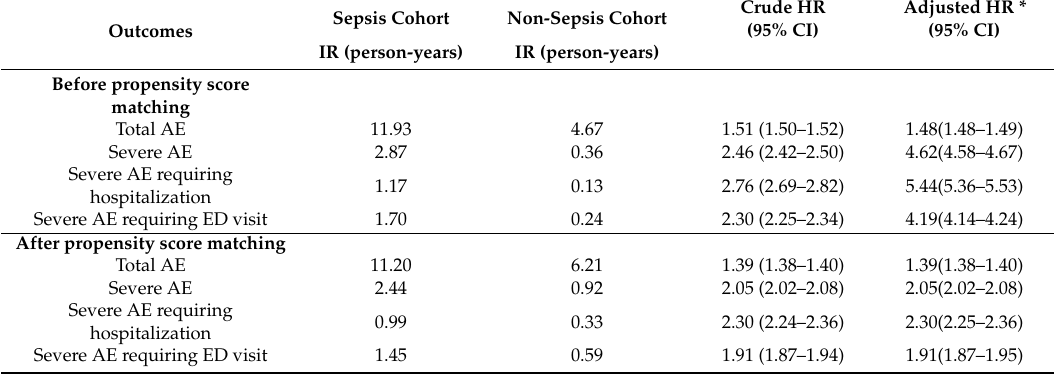
Table 2. Cumulative incidence rates and hazard ratios of COPD patients with acute exacerbation, severe acute exacerbation, severe acute exacerbation requiring hospitalization and ED visit before and after propensity score matching in sepsis and non-sepsis